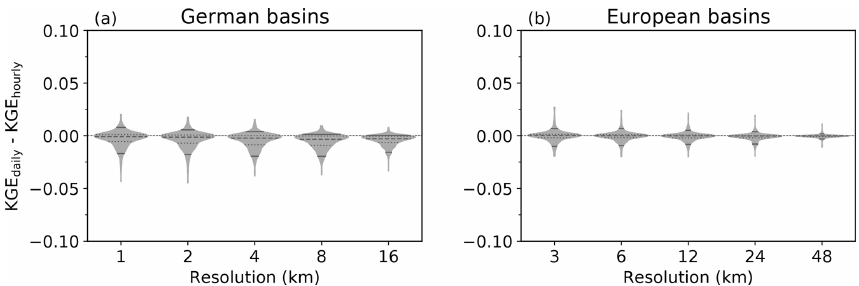
Figure 4. Probability density functions (PDFs) of differences in KGE values obtained with an hourly and daily input to the aTS. PDFs are limited to the minimum and maximum (cid:49) KGE values and have been normalised with respect to its width to ease the comparison. A thin dashed horizontal line is given at (cid:49) KGE = 0 for reference. Dashed lines in the violins indicate the medians, dotted lines the 25th and 75th percentiles, and solid lines the 5th and 95th percentiles.